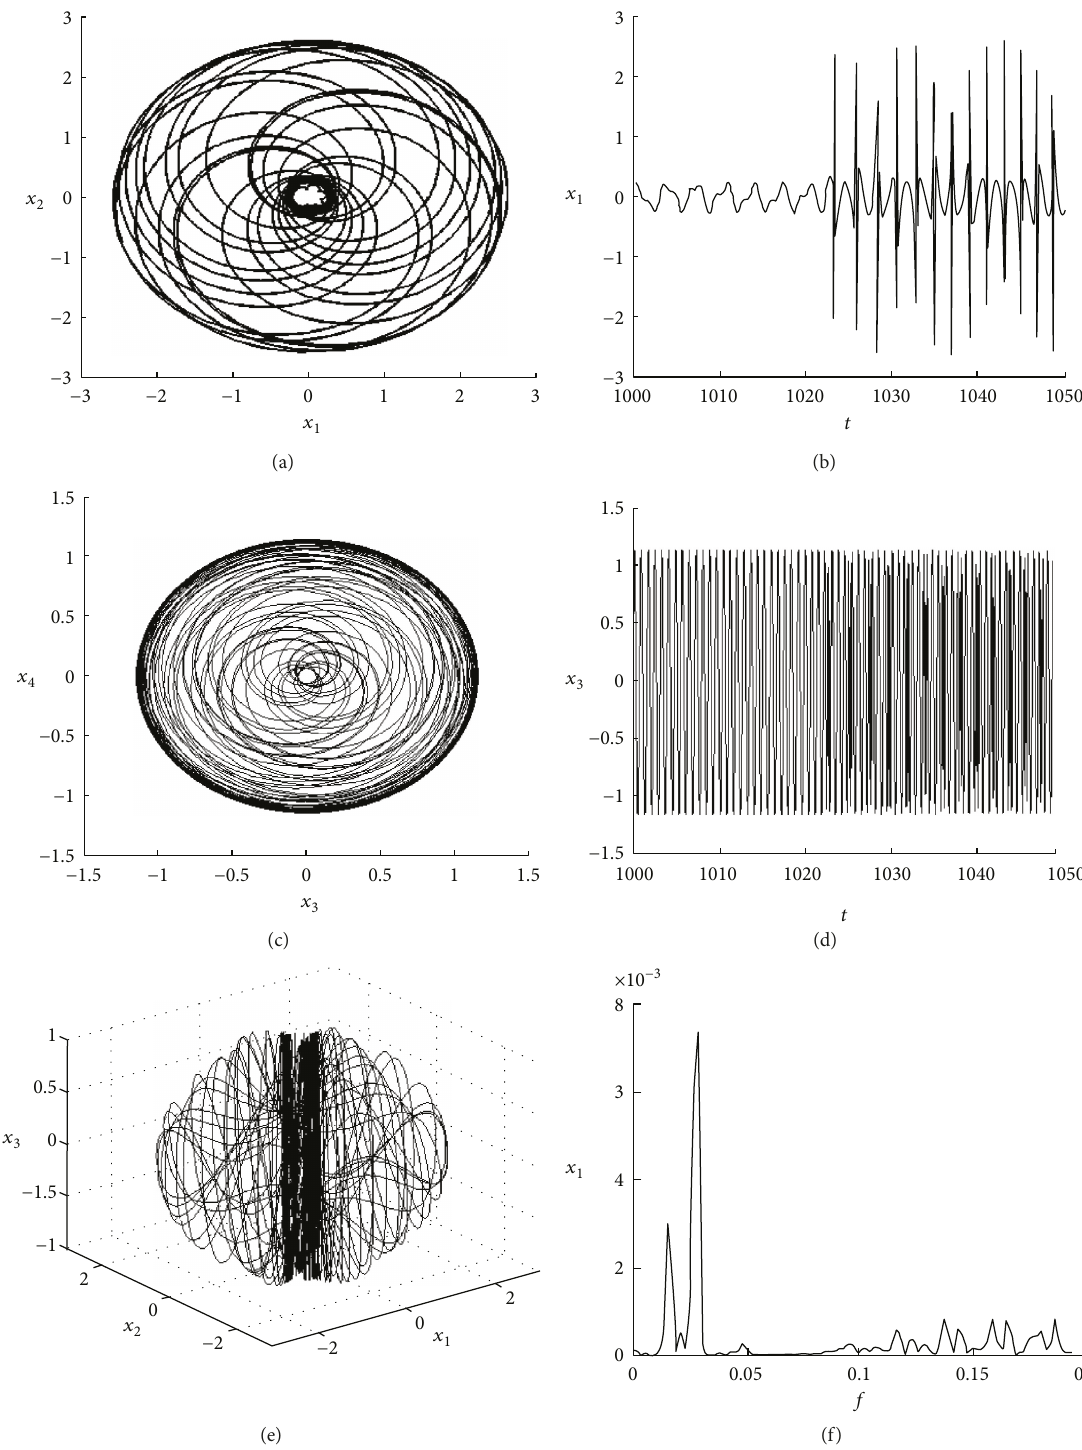
Figure 9: The chaotic motion of the blade with varying rotating speeds when Ω waveform on the plane t , x three-dimensional space x